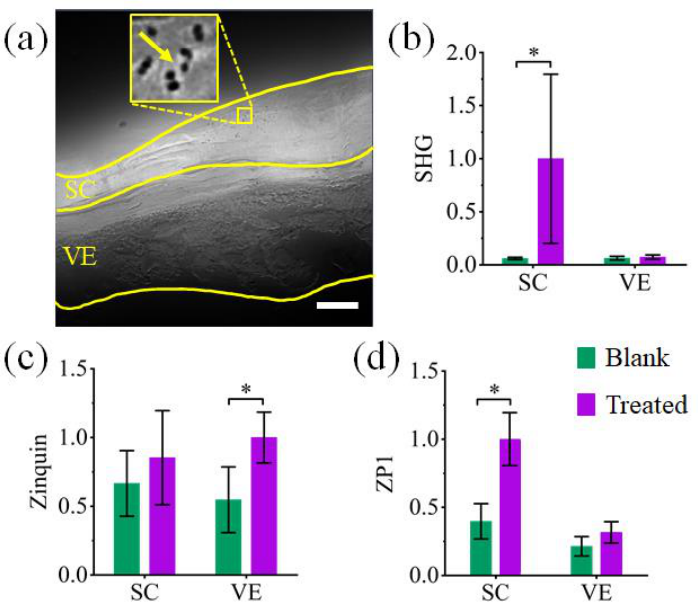
Figure 4. ( a ) Structured illumination microscopy image of ZnO-treated HSE. The inset is a magnified area of the image showing 67 ZnO-PEG NPs aggregates (pointed by a yellow arrow) on SC surface. Scale bar, 5 µ m. Results of image analysis of SHG, zinquin and ZP1 signals in untreated (Blank) and 67 ZnO-treated-HSEs (Treated). Bar plots compare the normalised intensities (mean ± 95% confidence interval, n = 7) of ( b ) SHG, ( c ) zinquin, and ( d ) ZP1 signals in SC and VE of blank and treated HSEs. (*) shows significance difference levels at p < 0.05.